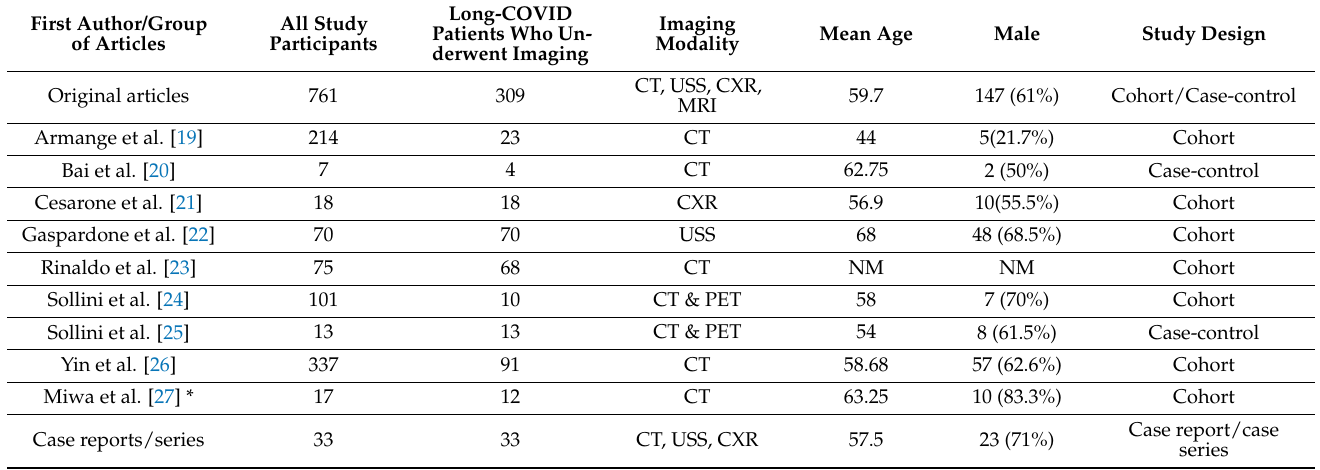
Table 1. Details of the original studies in this systematic review.